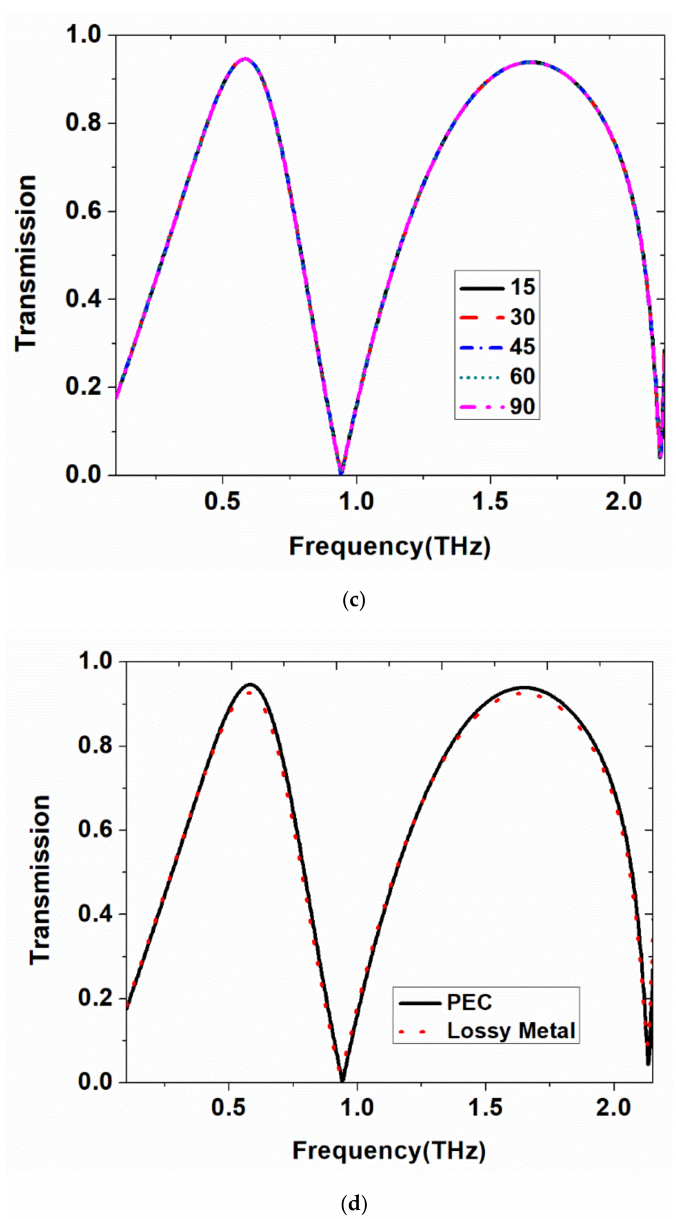
Figure 2. ( a ) Transmission characteristics of the proposed THz MM for TE and TM modes. ( b ) Trans- mission characteristics for different angles of incidence in TE mode. ( c ) Transmission characteristics for different angles of incidence in TM mode. ( d ) The proposed structure is evaluated for the lossy metal and compared with the